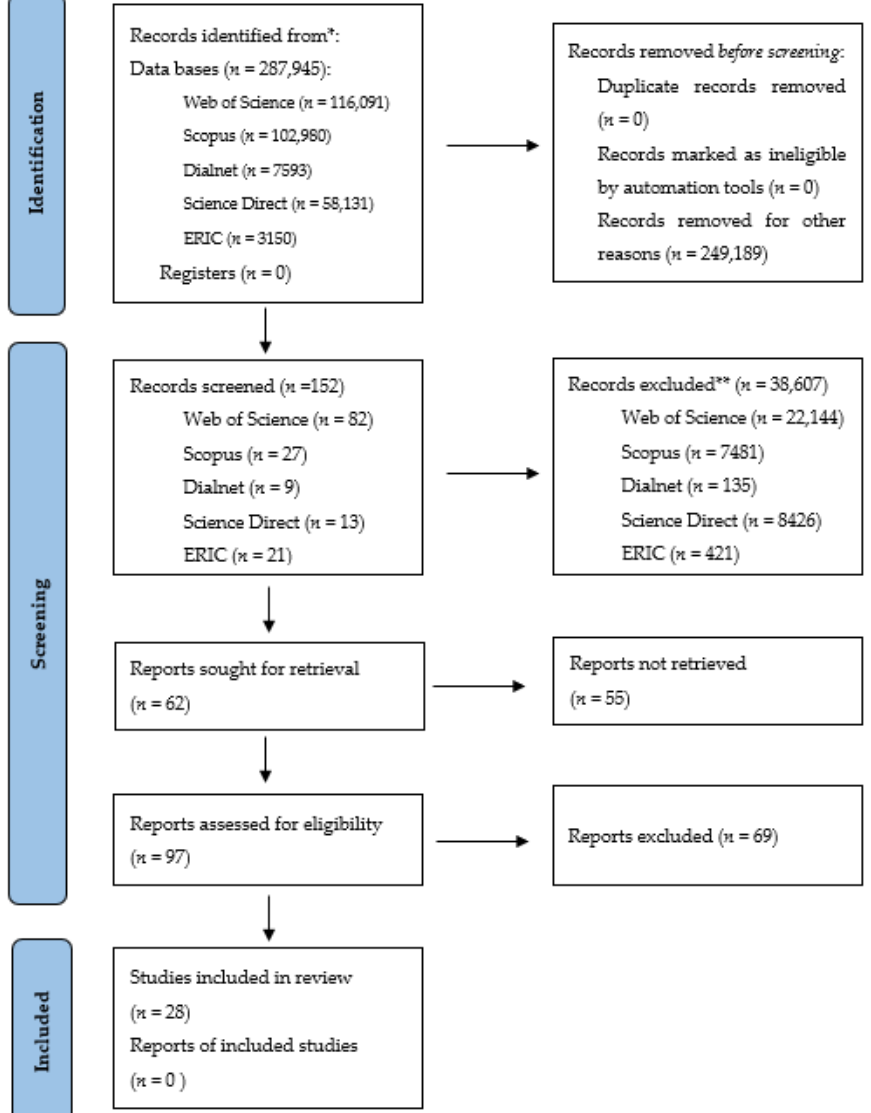
Figure 1. Selection criteria flow chart 1.